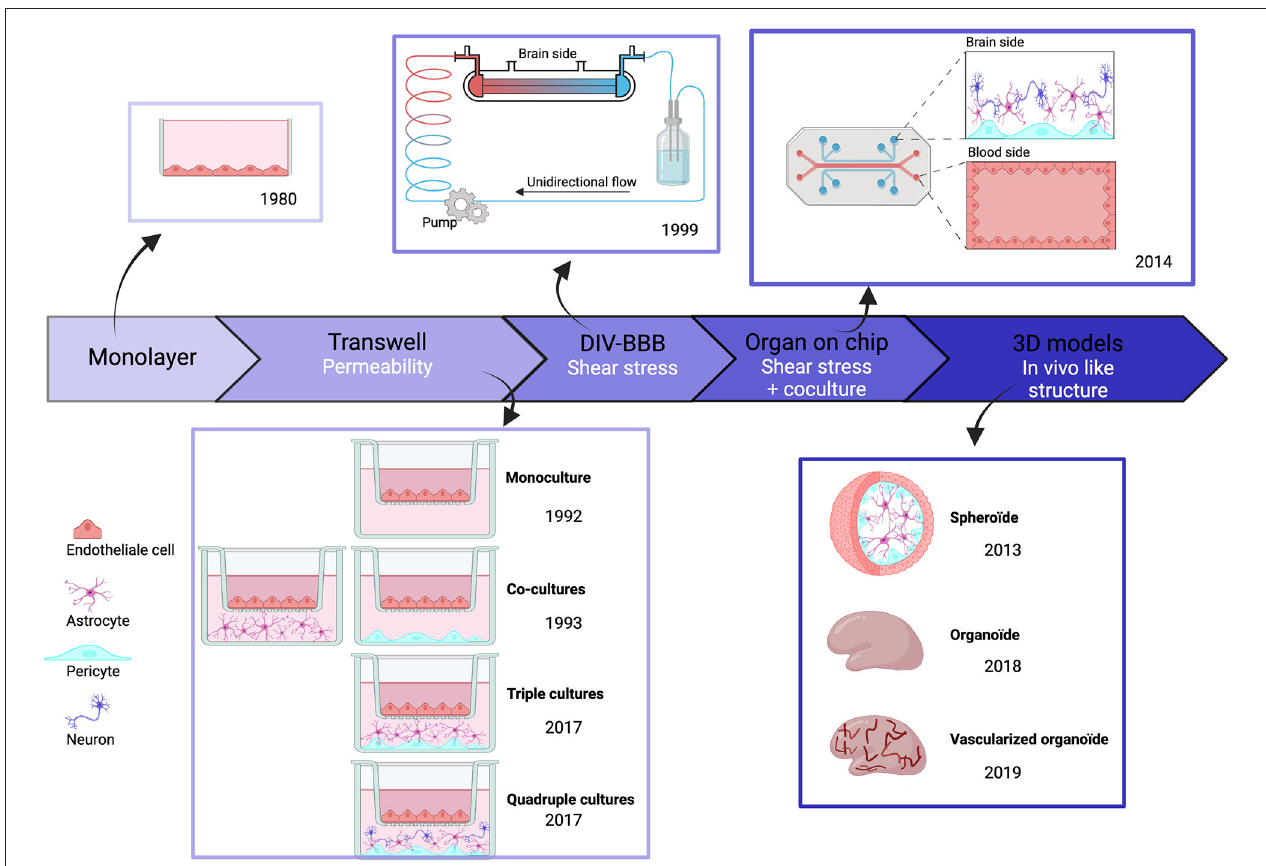
FIGURE 2 | Chronologic event in human BBB invitro models. Overtime, BBB models have evolved and became more complex to best reproduce physiological conditions. But each of these models have themselves evolved, in particular through the evolution of cell